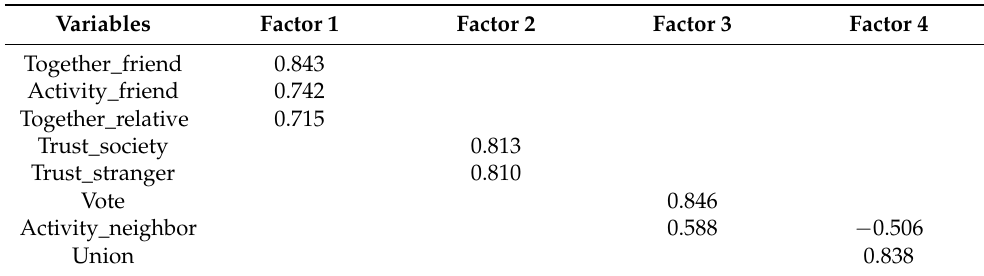
Table A4. Rotated Factor Matrix (2).